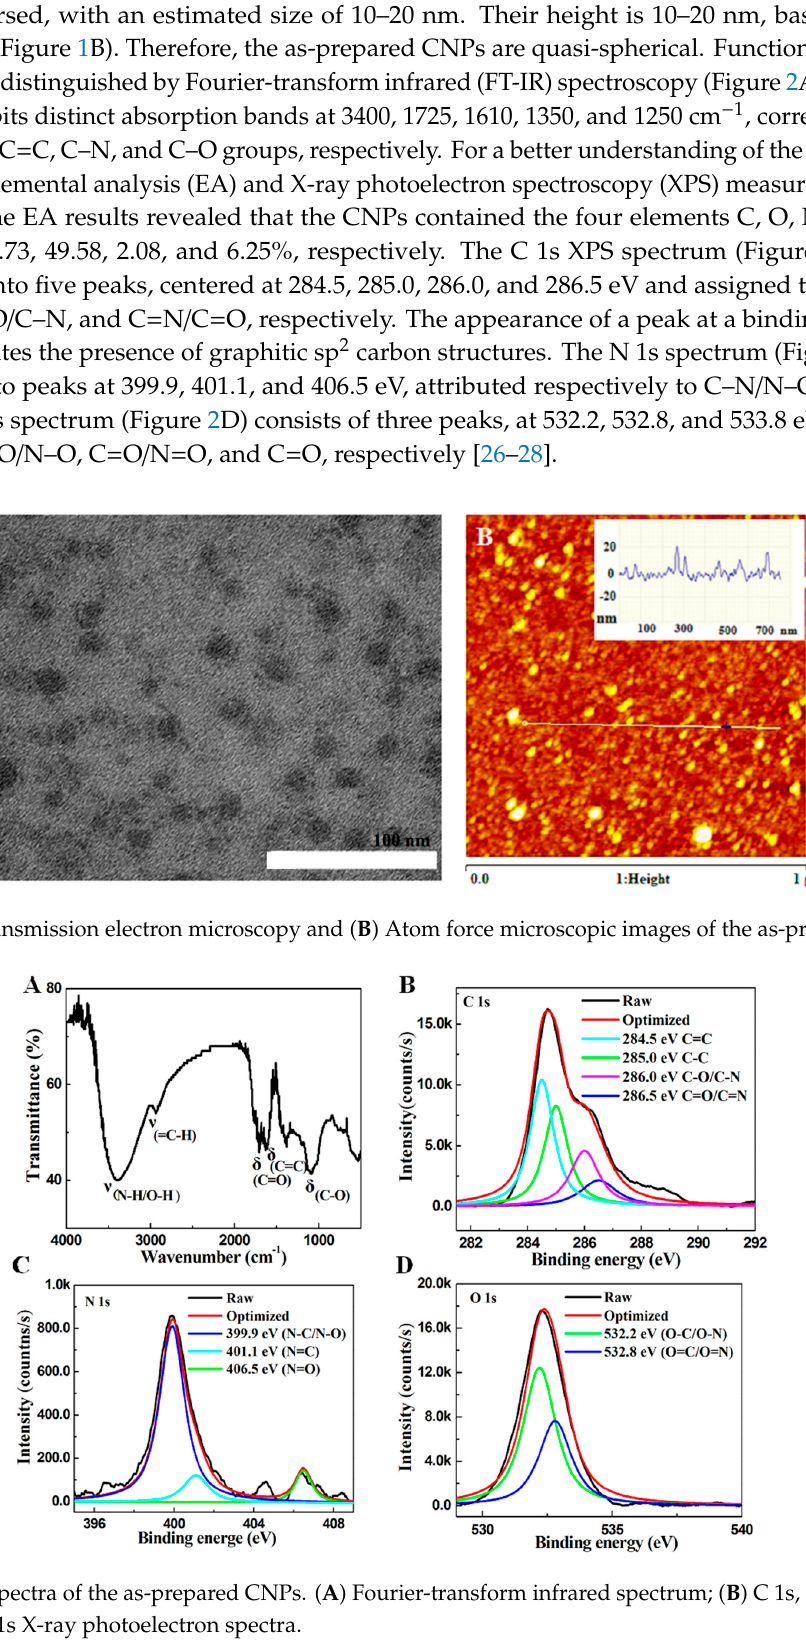
and ( D ) O 1s X-ray photoelectron